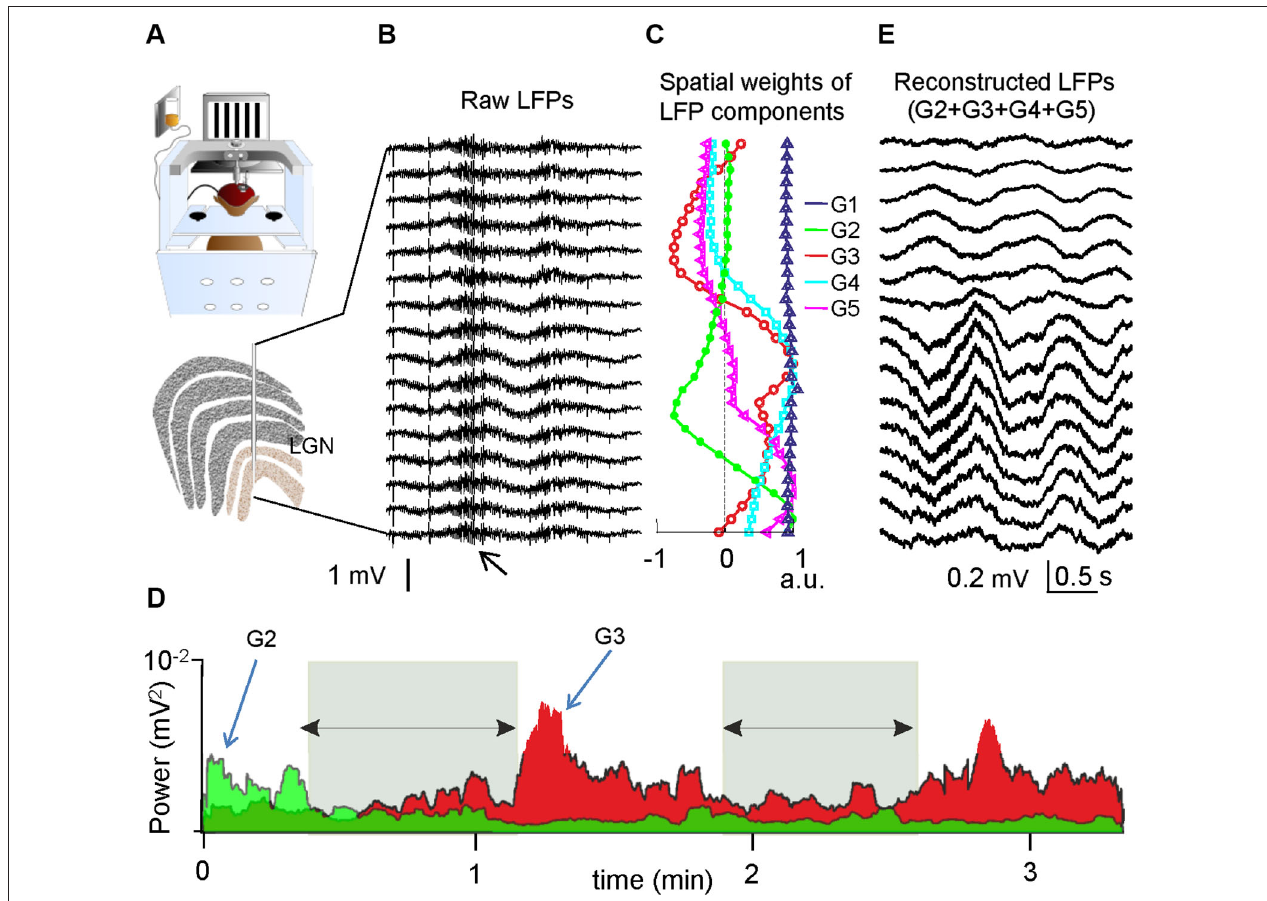
territories. (D) Evolution of the power in two LFP components (G2 and G3) in a sample epoch. The activity is specifically altered in some but not all components according to behavioral states. The periods marked by the horizontal arrows coincide with eye closure and somnolence. (E) Virtual LFPs can be reconstructed for a desired component or group, enabling close examination and quantitative use of the temporal details. These results were obtained by analyzing data in earlier studies (Rivadulla et al.,